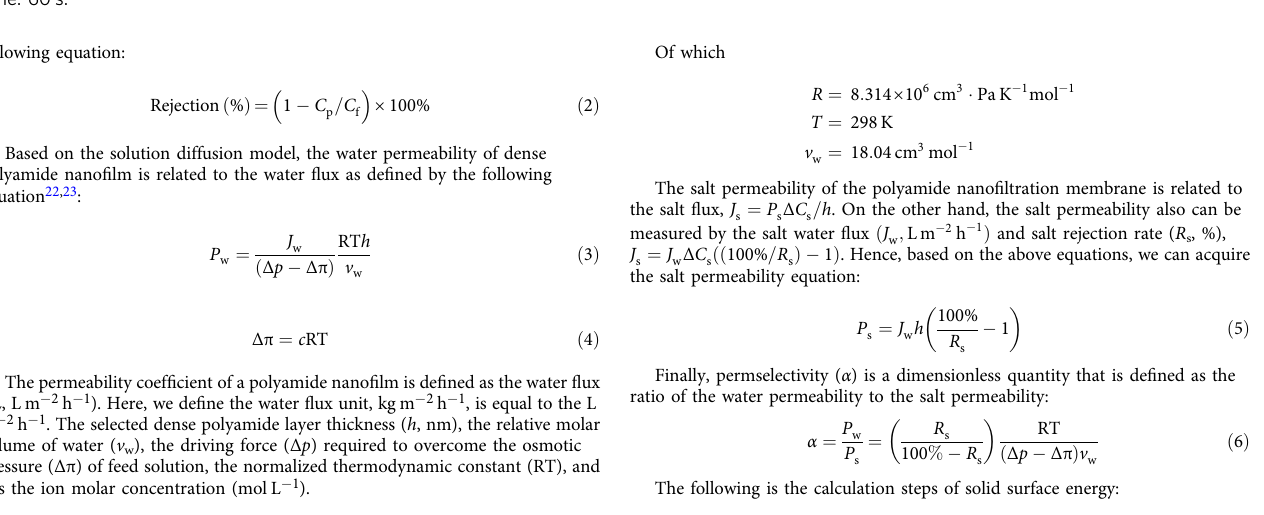
Fig. 7 Operational stability. a Operational stability of the asymmetric polyamide membrane. b TEM image of the asymmetric polyamide nano fi lm. c SEM cross-section image of the asymmetric polyamide nano fi lm. The asymmetric polyamide nano fi lm was prepared on the PSF-G4D-1 substrate, reaction time: 60